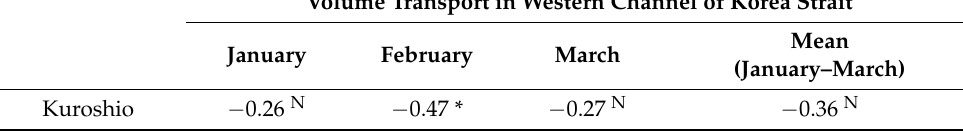
Table 1. Correlation coefficient between volume transport in western channel of Korea Strait and Kuroshio Current intensity.